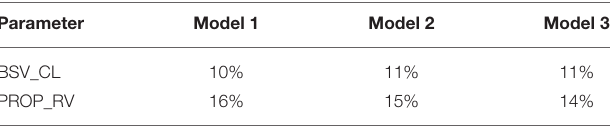
TABLE 8 | Shrinkage of empirical Bayes estimates (EBEs) of Model 1, Model 2, and Model 3.